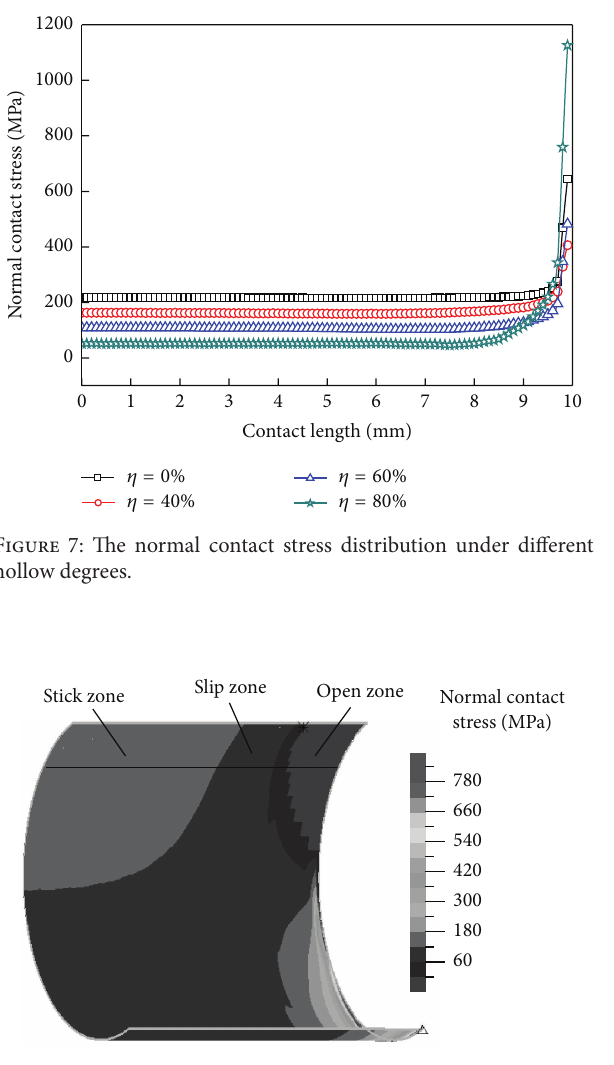
Figure 8: Normal contact stress distribution.